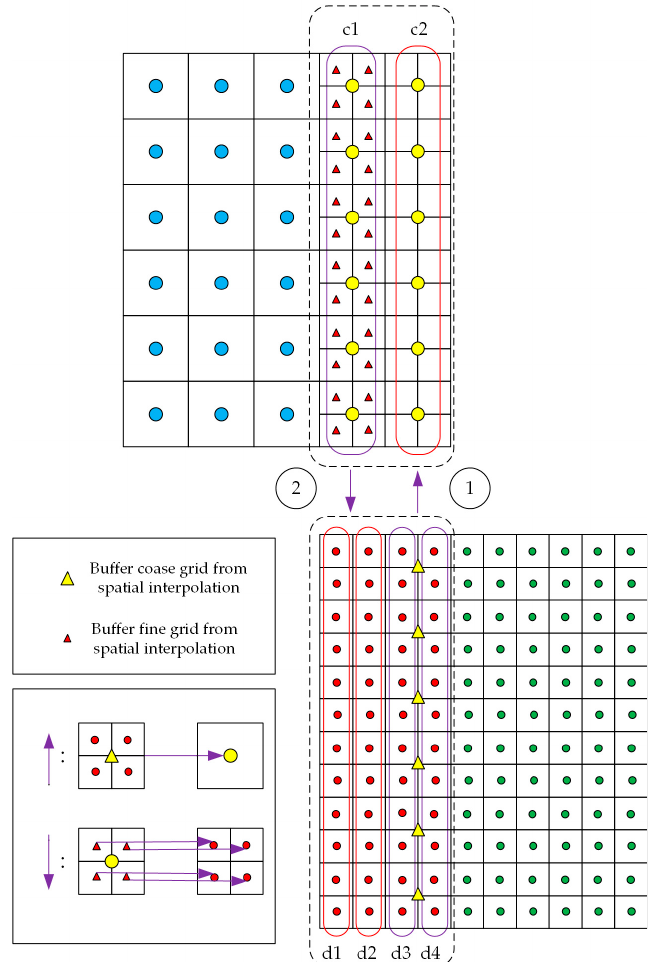
Figure 12. Data transfer between coarse and fine grids in the buffer.